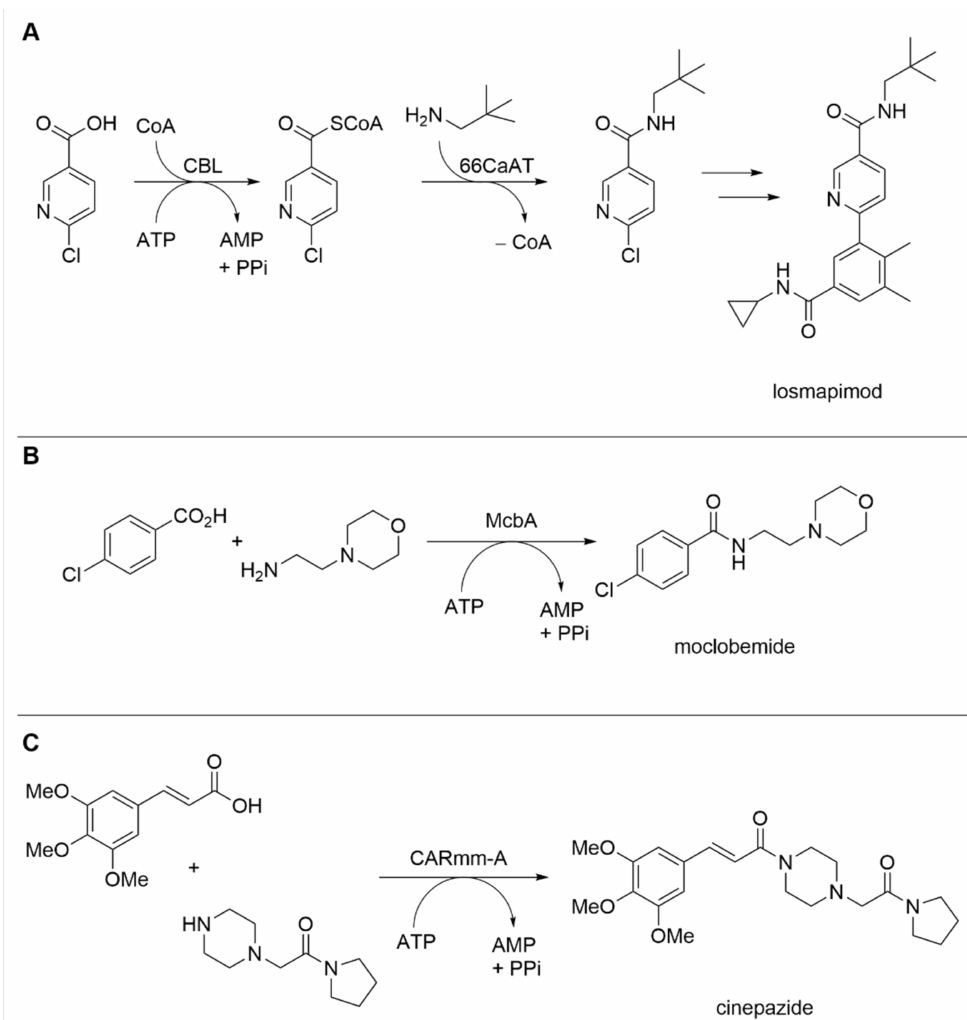
Figure 2. Novel biocatalytic routes to access amides. ( A ) Synthesis of a key intermediate of losmapimod from 6-chloronicotinic acid, and neopentylamine utilizing a 4-chlorobenzoate CL from Alcaligenes sp. (CBL), and serotonin hydroxycinnamoyl transferase from Capsicum annuum (66CaAT) [16]. ( B ) McbA catalyzed synthesis of moclobemide from para -chlorobenzoic acid, and 4-(2- aminoethyl)morpholine [17]. ( C ) Synthesis of cinepazide by the truncated carboxylic acid reductase from Mycobacterium marinum CARmm-A